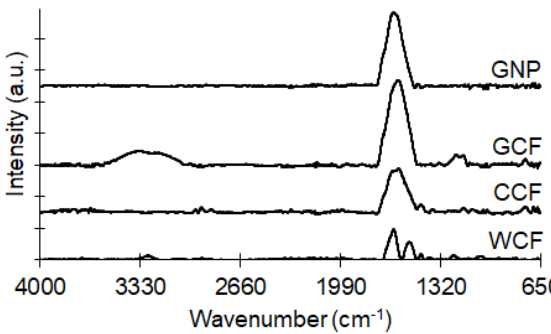
Figure 7. ATR–FTIR spectra of GNP, GCF, CCF, and WCF.